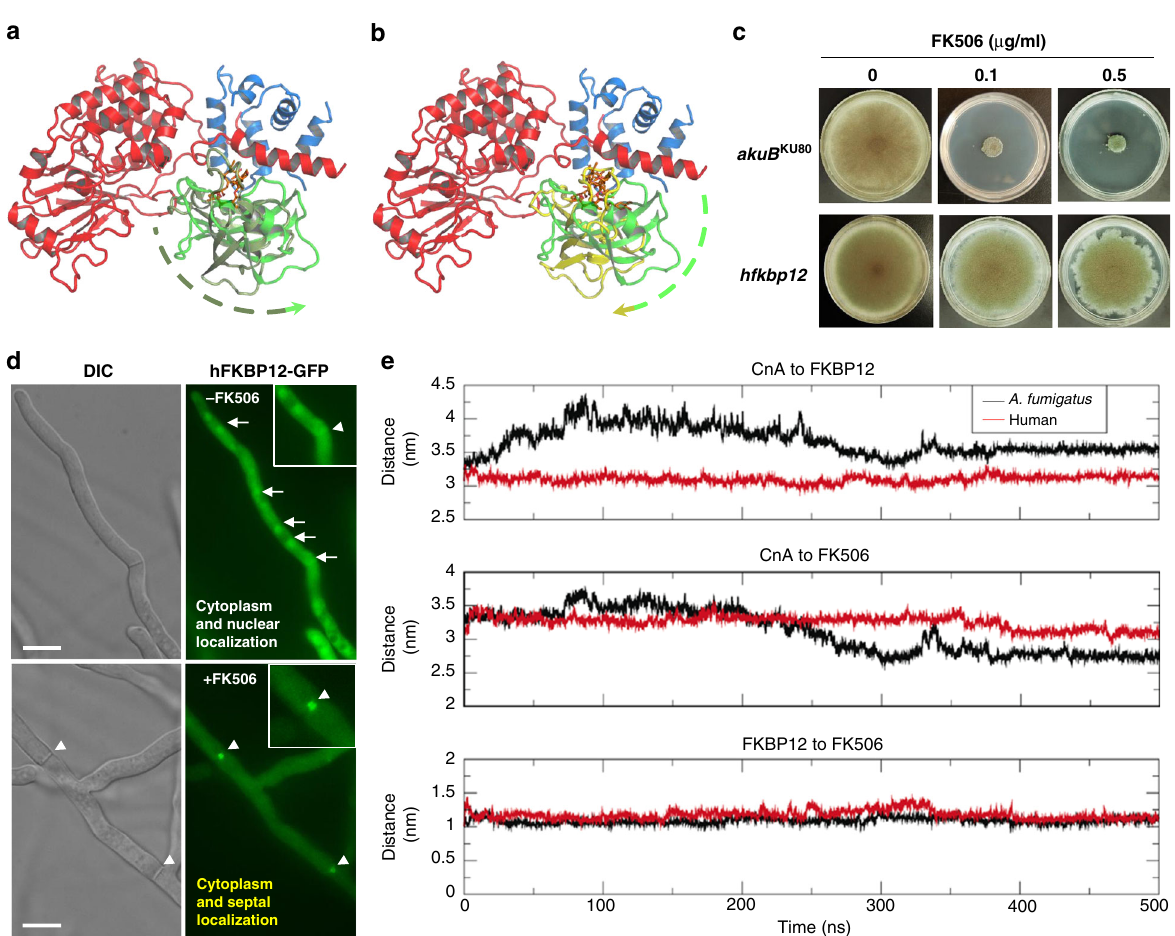
Fig. 3 X-ray and MD-simulated structures of A. fumigatus and human CN-complex. a Conformational rotation of FKBP12 about the FK506-binding pocket comparing the X-ray characterized and MD characterized CnA (red)/CnB(blue) – FKBP12 [olive (X-ray) and green (MD simulated)] – FK506 complex. b Conformational rotation of FKBP12 about the FK506-binding pocket comparing the MD characterized A. fumigatus complex and the MD characterized human CnA (red)/CnB(blue) – FKBP12 [green ( A. fumigatus ) and yellow (human)] – FK506 complex. Rotation in a and b are depicted by dashed arrow lines color coded based on the FKBP12 coloring in each panel. c Growth of the A. fumigatus strain expressing codon-optimized hFKBP12 in the absence and presence of FK506 for 5 days at 37 °C. d Microscopic localization hFKBP12-GFP in A. fumigatus in the absence or presence of FK506. Arrows show nuclear localization of hFKBP12. Arrowheads indicate the binding of hFKBP12 to CN at the hyphal septum. e Center of mass (COM) distances between different chains convey the stability of the complexes over the last 100 ns; top — CnA to FKBP12, middle — CnA to FK506, and bottom — FKBP12 to FK506. See